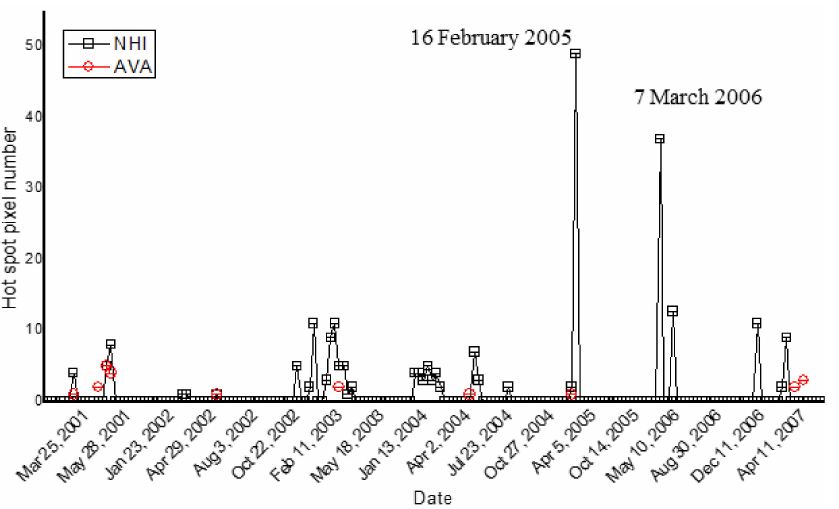
Figure 11. Hot pixels flagged by NHI (black squares) and AVA (red dots) at Telica (Nicaragua) volcano, from ASTER data of March 2000–2008. Note that a number of AVA detections (i.e., those of 9 March 2001; 10 April 2001, 11 February 2003; 26 March 2007; 11 April 2007) were outside the area analyzed by NHI.